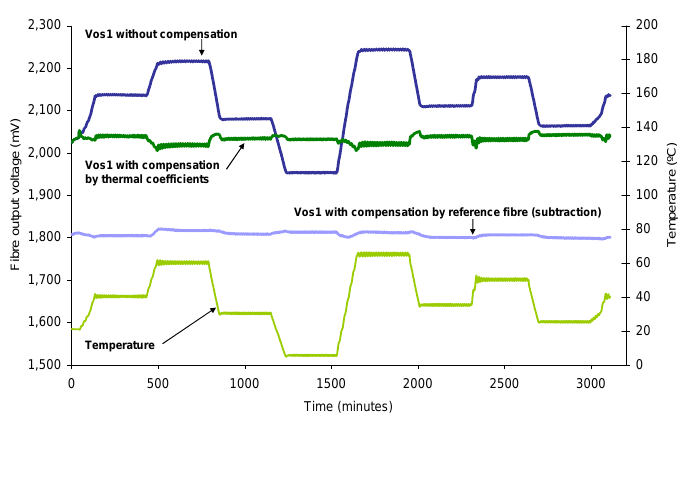
Figure 9. Compensation by data processing, comparison between the compensation by the reference fiber and the thermal coefficients method.